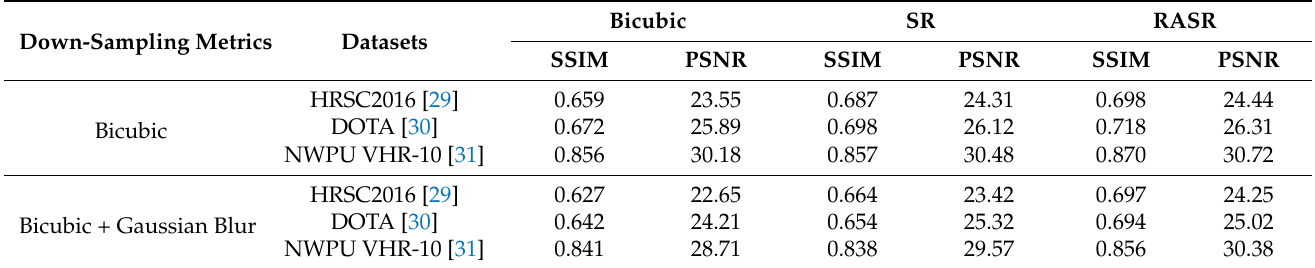
Table 1. Quantitative evaluation results of image quality achieved by different variants of our proposed RASR. We use SSIM and PSNR as the evaluation